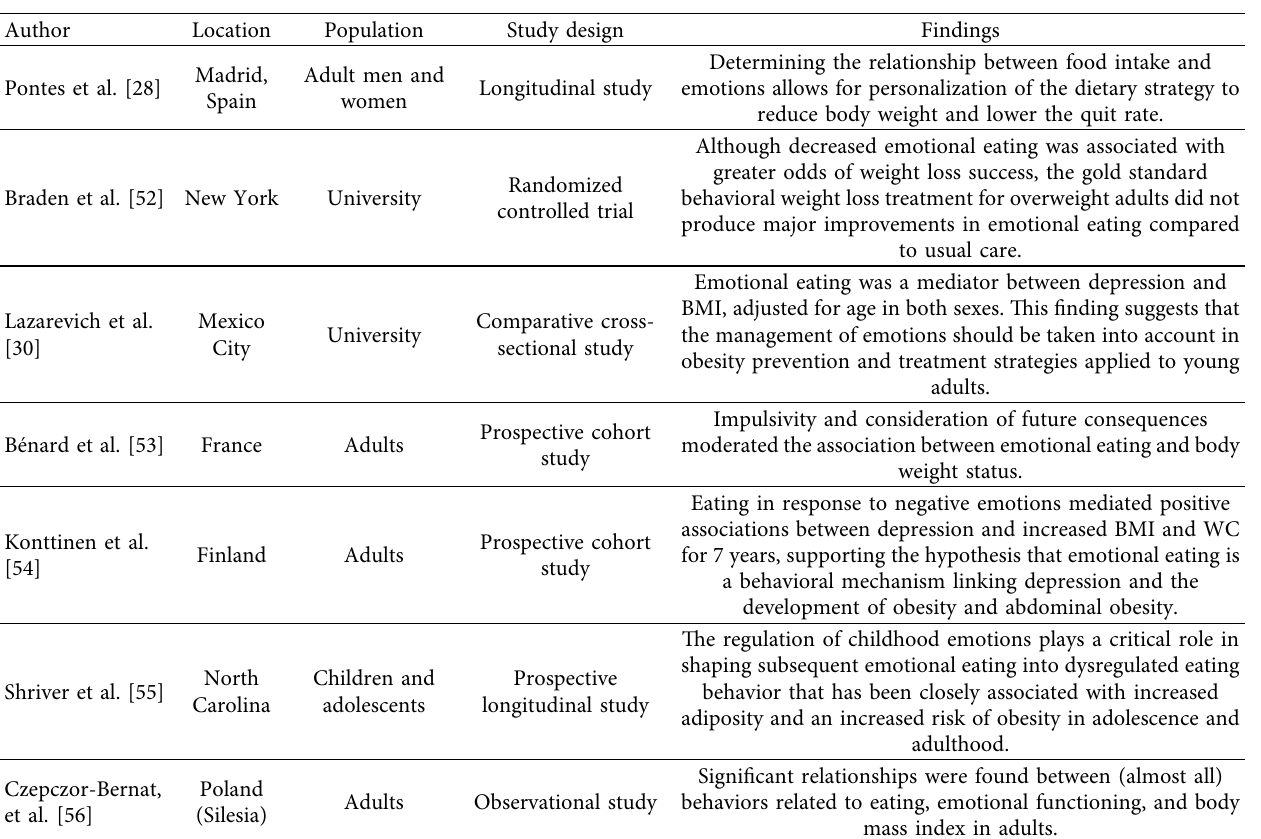
Table 5: Studies that report a relationship between the intake of hyperpalatable energy-dense foods, emotional eating, and indicators of nutritional